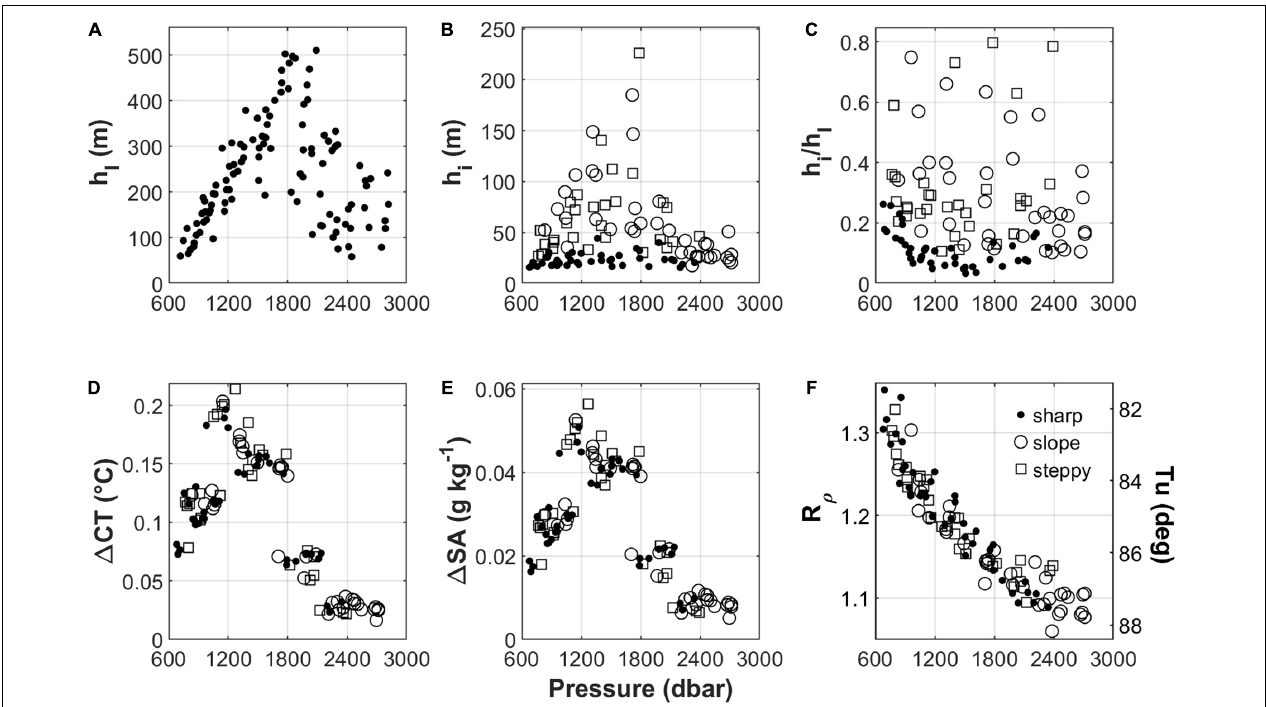
FIGURE 8 | Main features of the staircase system vs. pressure (dbar). (A) Layer thickness (m), referring to the midpoint of the layer. (B) Interface thickness (m), referring to the midpoint of the interface. (C) Ratio between the thickness of the interface and the underlying layer. (D,E) Differences of the temperature ( ◦ C) and the salinity (g kg − 1 ) across an interface. (F) Density ratio (left axis) and the correspondent values of the Turner angle (right axis). In (B–F) , the values corresponding to the different types of interfaces (sharp, slope, steppy) are denoted by the symbols ascribed to them in the legend of (F)